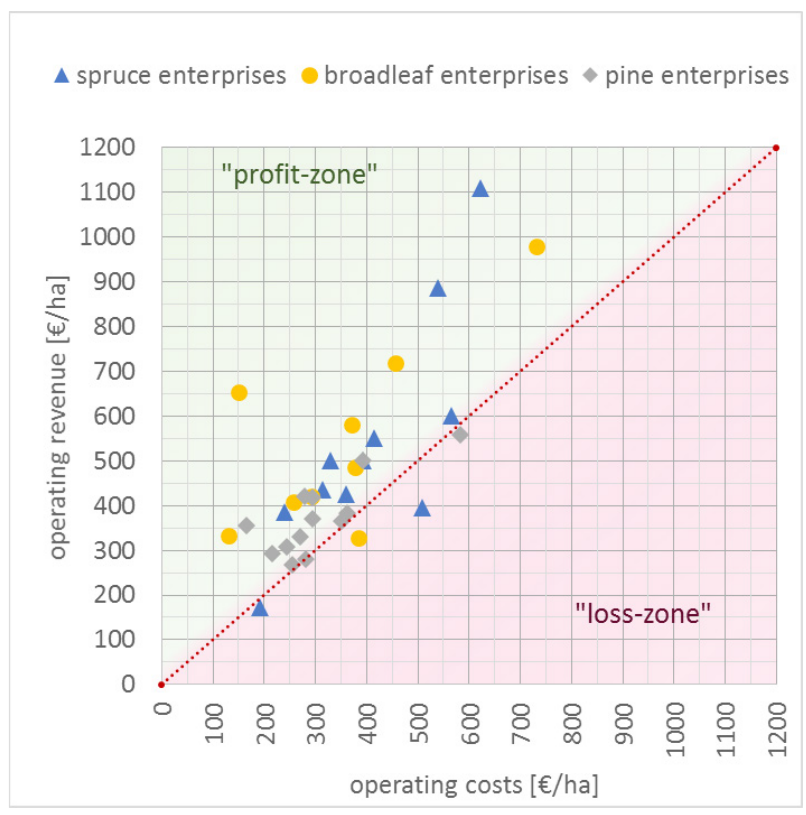
Figure 3: Income and expenses of the enterprises according to consultancy circles in 2015